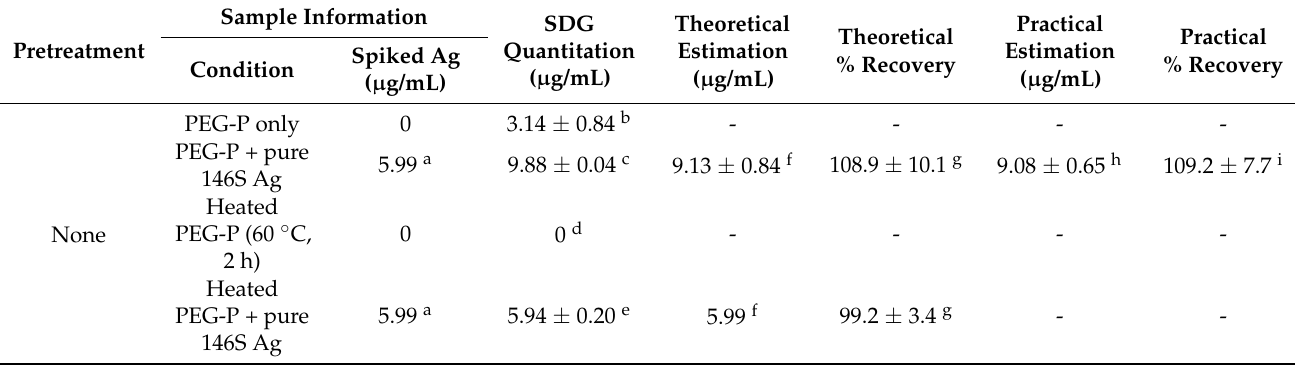
Table 4. A spiking test result by SE-HPLC for the validation of the pretreatment method for PEG-P.